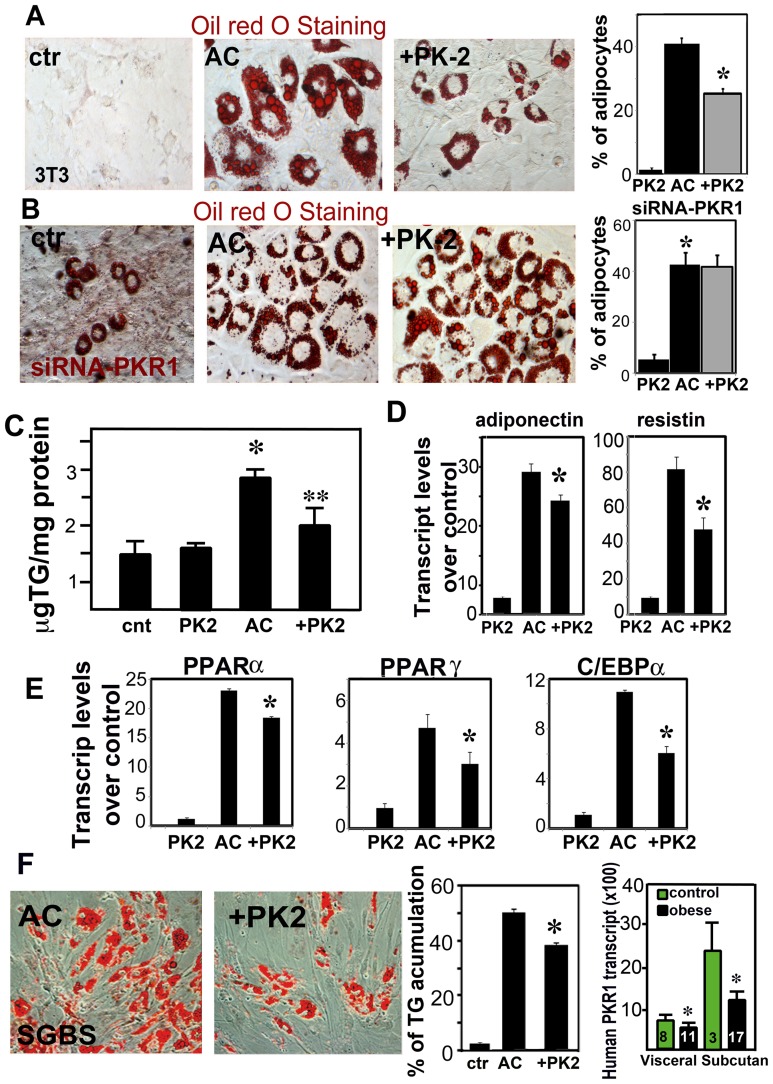
Prokineticin-2 inhibits preadipocyte conversion to adipocytes.A) Oil-red O staining of 3T3-L1 cells treated with control (ctr), adipogenic cocktail (AC) for 8 days or pretreated with 5 nM of prokineticin-2 (+PK-2) 10 h before AC treatment (n = 20, *p<0.05, HPF, ×40 objective). B) In the PKR1 knockdown 3T3-L1 cells (siRNA-PKR1), prokineticin-2 (5 nM) pretreatment did not able to inhibit adipogenesis induced by AC. Histogram shows pretreatment of adipocytes with prokineticin-2 reduced number of adipocytes detected by Oil red staining in the control siRNA transfected 3T3-L1 cells but not in the PKR1 siRNA transfected cells (n = 20, *p<0.05, HPF, ×40 objective). C) Triglyceride (TG) accumulation in the cell lysates. * shows PK2 significantly diminished AC effect (n = 3, p<0.05). D) qPCR analyses show increased levels of mature adipocyte markers, resistin and adiponectin by AC that was inhibited by prokineticin-2 as compare to that of AC (n = 3, p<0.05). E) qPCR analyses reveal that PPARα, PPARγ and C/EBPα, were significantly reduced by prokineticin-2 pretreatment as compare to that of AC (n = 3, p<0.05). F) Representative illustration and histogram shows that prokineticin-2 reduced human preadipocyte SGBS cell differentiation into adipocytes and TG accumulation induced by AC (n = 3, p<0.05). Quantitative PCR analyses show that transcript levels of human PKR1 (right panel) were reduced in obese visceral and subcutaneous human tissues (n is indicated in the figure, *p<0.05).